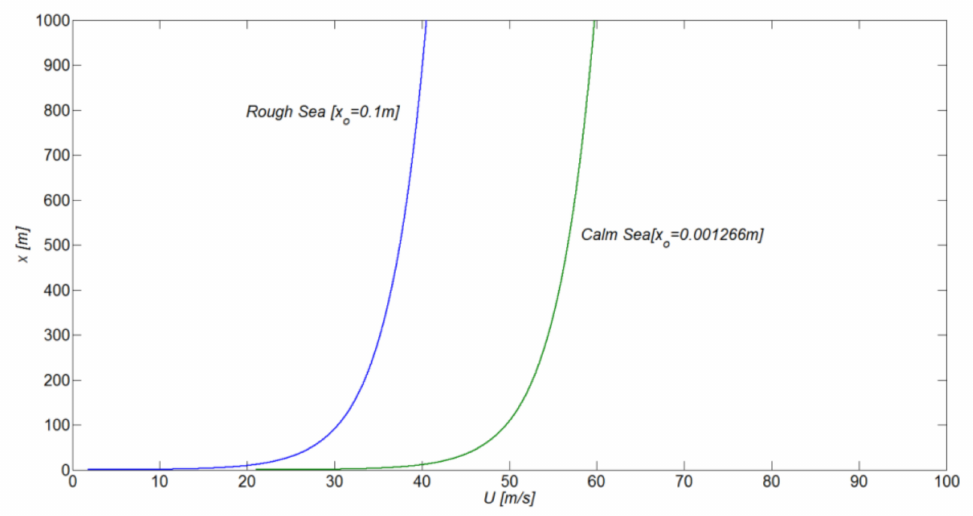
Figure 23. Comparison of mean wind velocity over rough seas with the one over calm sea.